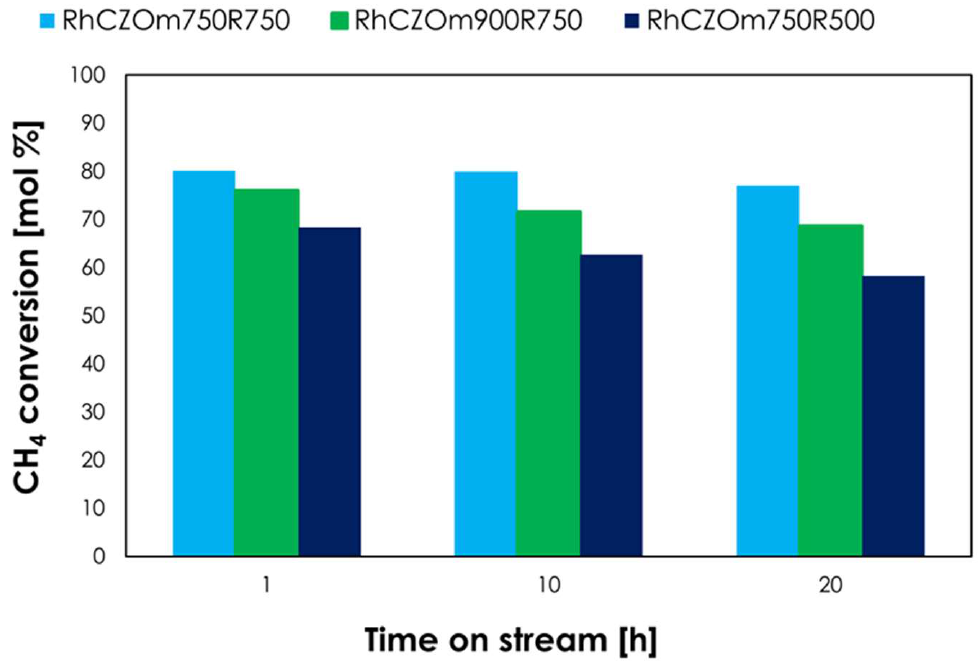
Figure 13. Methane conversion over time on stream in repeated tests carried out at 750 °C, 24,000 h −1 and 1 bar for the investigated catalysts.